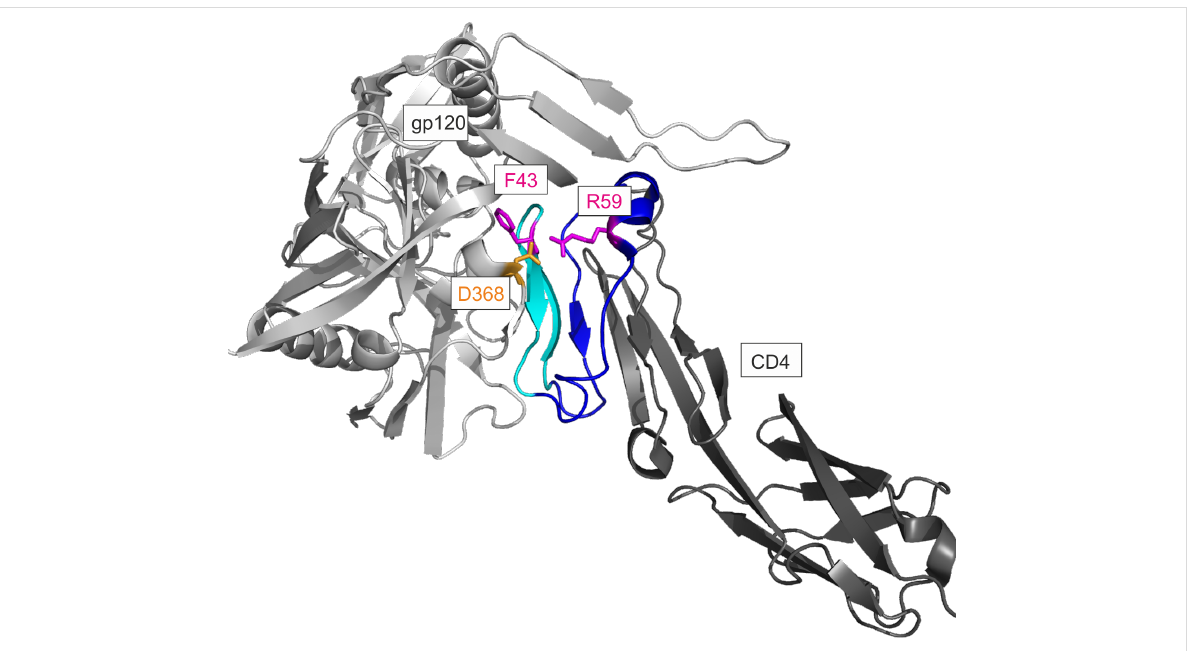
Figure 1: Structural details of the CD4–gp120 complex (pdb 1rzj). The binding site of CD4 for gp120 is shown in blue (residues 22–33 and 49–64) and in cyan (CDR2-like loop, residues 34–48). The key residues for the interaction with gp120 (F43 and R59) are depicted in purple, and the contact residue D368 of gp120 in